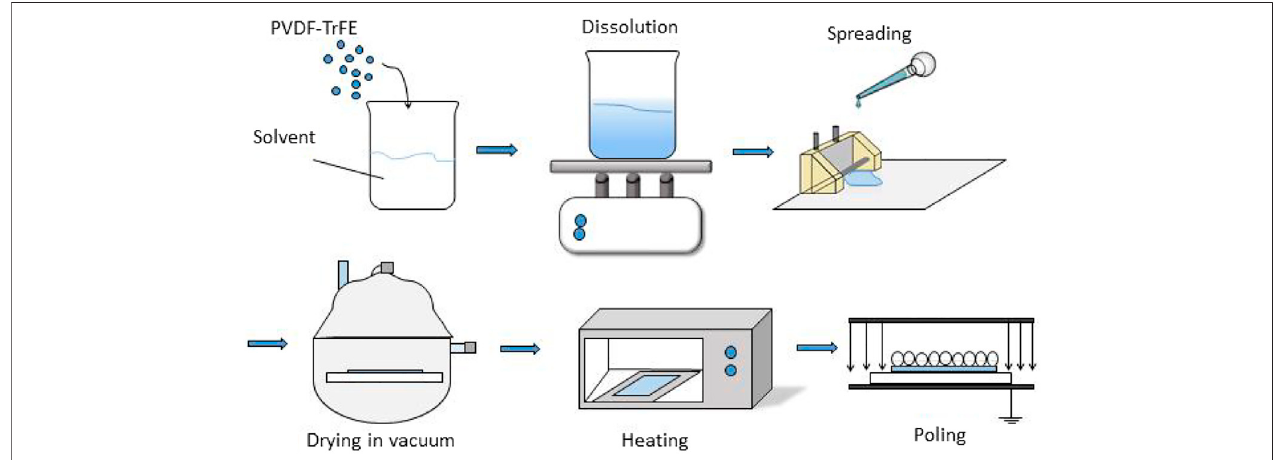
FIGURE 1 | Preparation process of PVDF-TrFE fi lms.